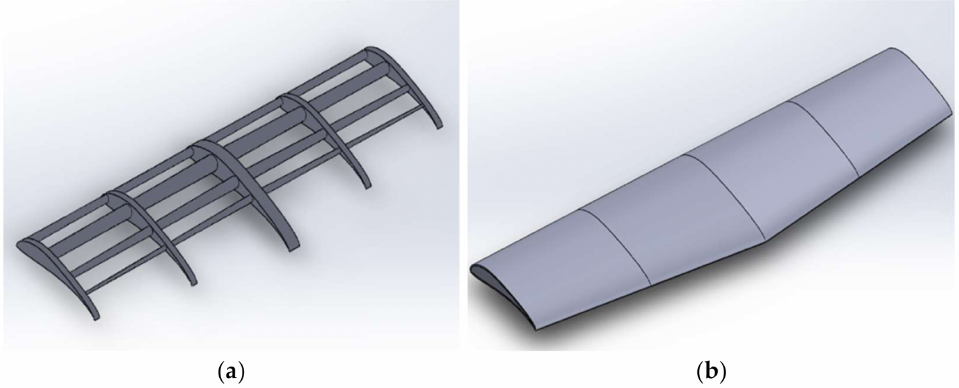
Figure 10. ( a ) The internal structure of the wing and ( b ) complete wing structure.